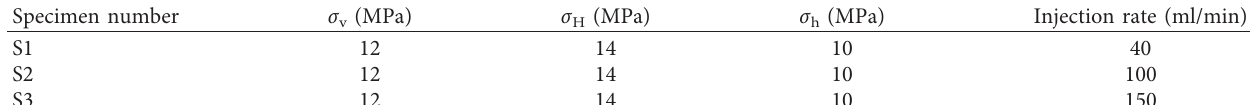
Table 2: Test conditions for hydraulic fracturing.